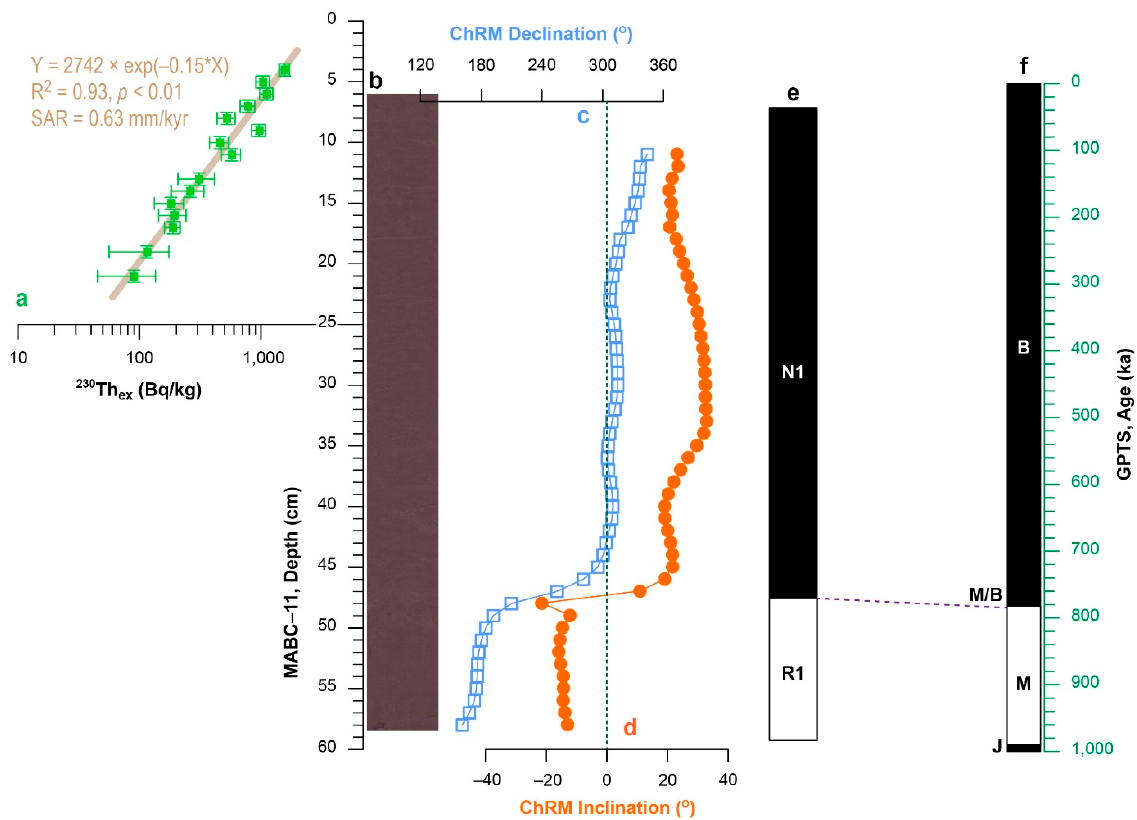
Figure 3. Magnetostratigraphy of core MABC–11. ( a ) The excess 230 Th data and the estimated sediment accumulation rate (SAR) for the upper part [19]; ( b ) photo of the core; ( c , d ) ChRM declination and inclination, respectively; ( e ) the polarity of core MABC–11 with two identified magnetozones; ( f ) The geological polarity timescale (GPTS) [38]. B, Brunhes chron; M, Matuyama chron; J, Jaramillo subchron; M/B, the Matuyama/Brunhes boundary (0.781 ka).